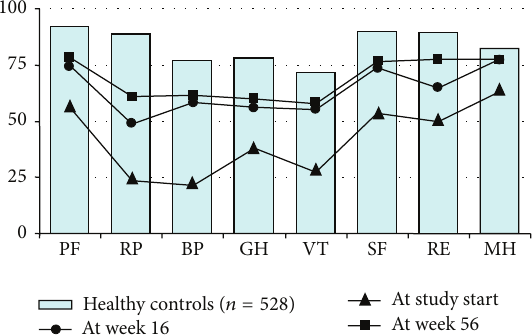
Figure 5: The patients’ health related quality of life measured by SF- 36. The graph shows the mean scores for the eight SF-36 domains for the normal population and the patients with AS at baseline, at 16 weeks, and at 56 weeks. A significant improvement in patients’ health related quality of life was observed at weeks 16 and 56 as compared with